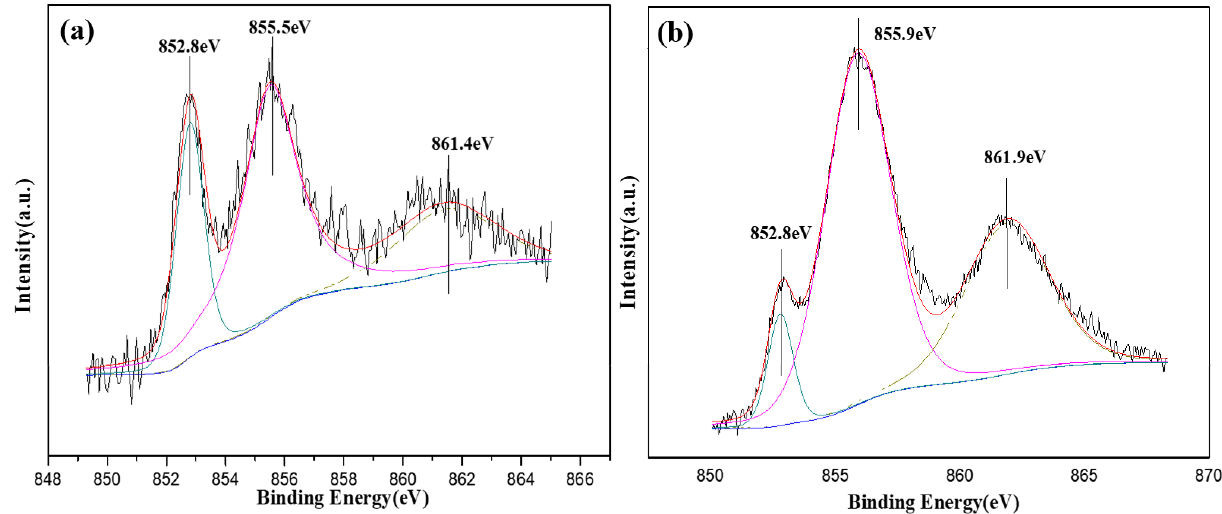
Figure 9. Peak splitting processing for Ni in the corroded alloy coatings at the ground state and with treatment at 400 °C: ( a ) Ni in the coating at ground state, and ( b ) Ni in the coating with treatment at 400 °C.